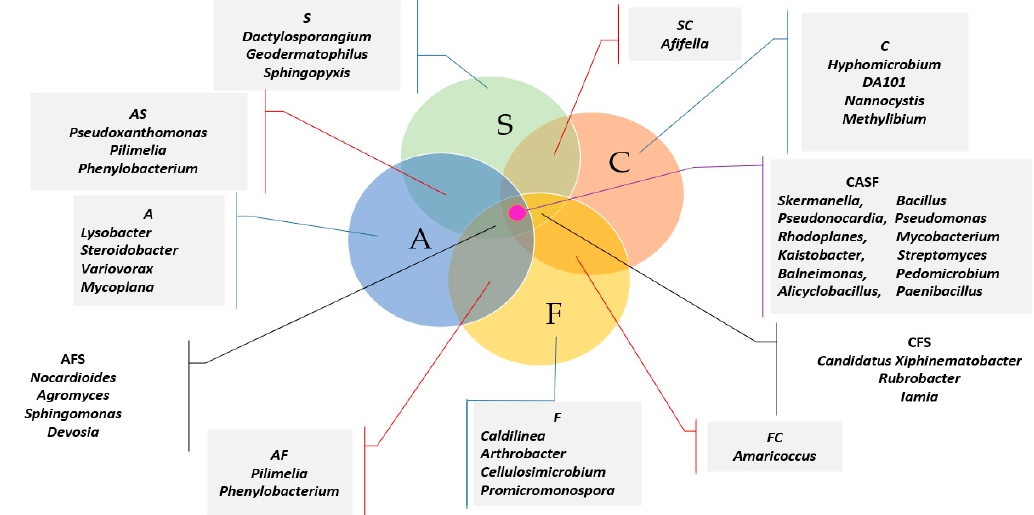
Figure 9. Venn diagram showing unique and common types of bacteria, based on all OTU data. C—uncontaminated soil; A—soil contaminated with BPA; F—soil contaminated with BPF; S—soil contaminated with BPS.